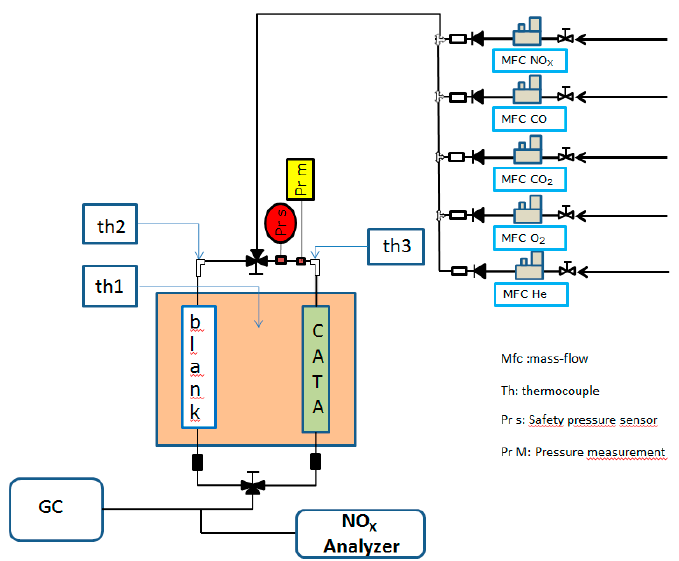
Figure 1. Experimental setup for catalytic purification of CO 2 from oxyfuel combustion.